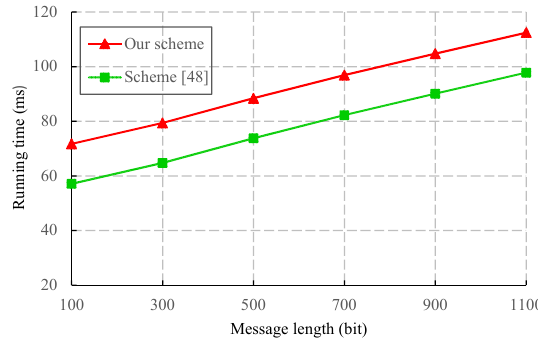
Figure 8. A comparison of the signature verification cost between CLS-based and SDVPRS-based authentication